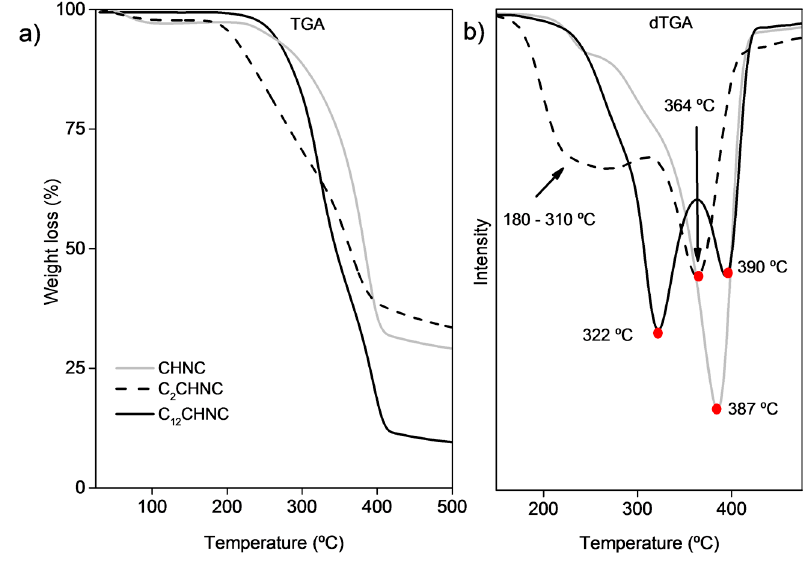
Figure 4. TGA ( a ); and dTGA ( b ) profiles of CHNC, C 2 CHNC and C 12 CHNC. Table 2. Degradation temperatures of CHNC, C 2 CHNC, C 12 CHNC and PLA-based nanocomposites. Sample Temp. Main Degradation (°C) Temp. Second Degradation (°C)